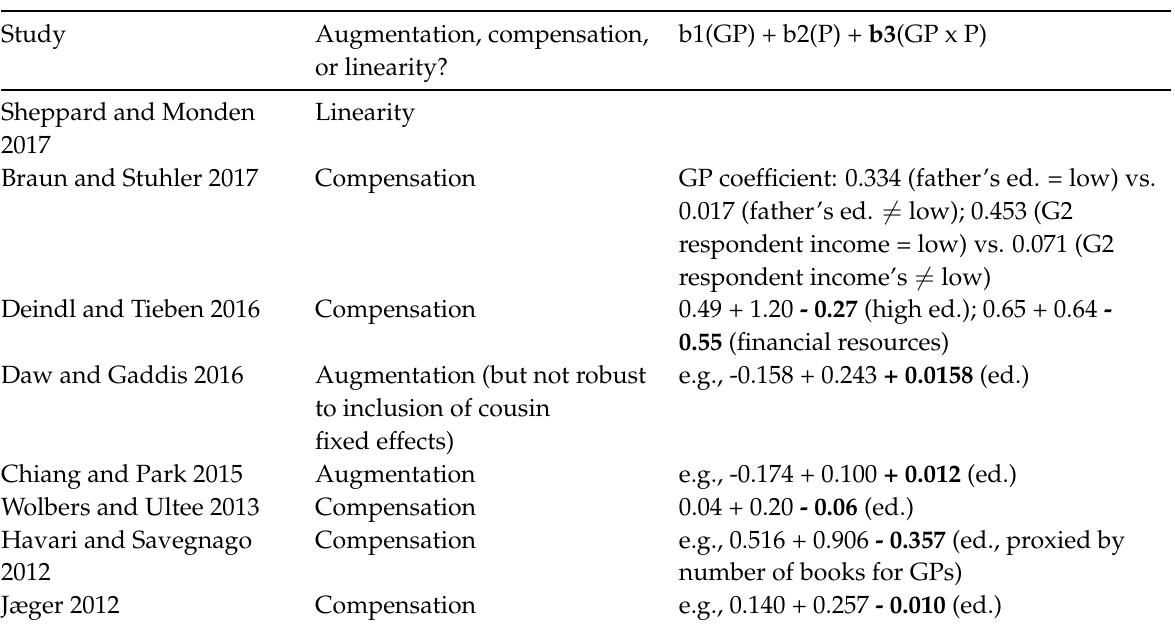
Table 3: Studies testing interactions of grandparent and parent